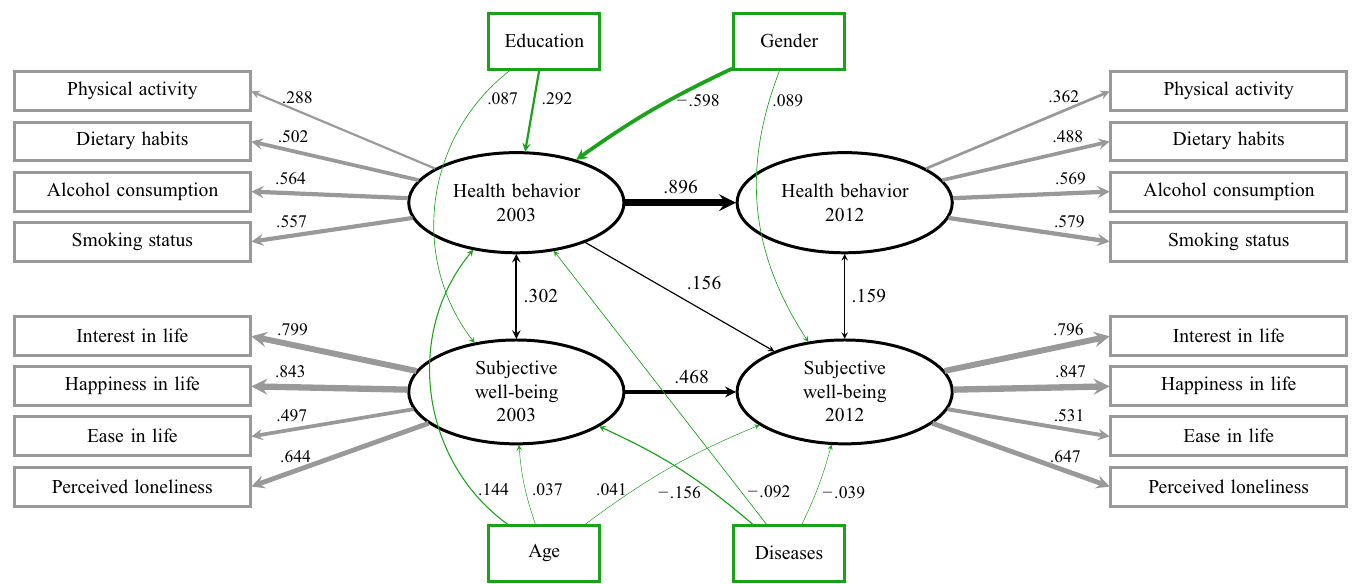
Fig 3. Path diagram of final structural equation model. The structural equation model showing standardized path coefficients for cross-lagged, cross-sectional, and longitudinal connections for health behavior and subjective well-being in a nine-year follow-up adjusted for covariates.